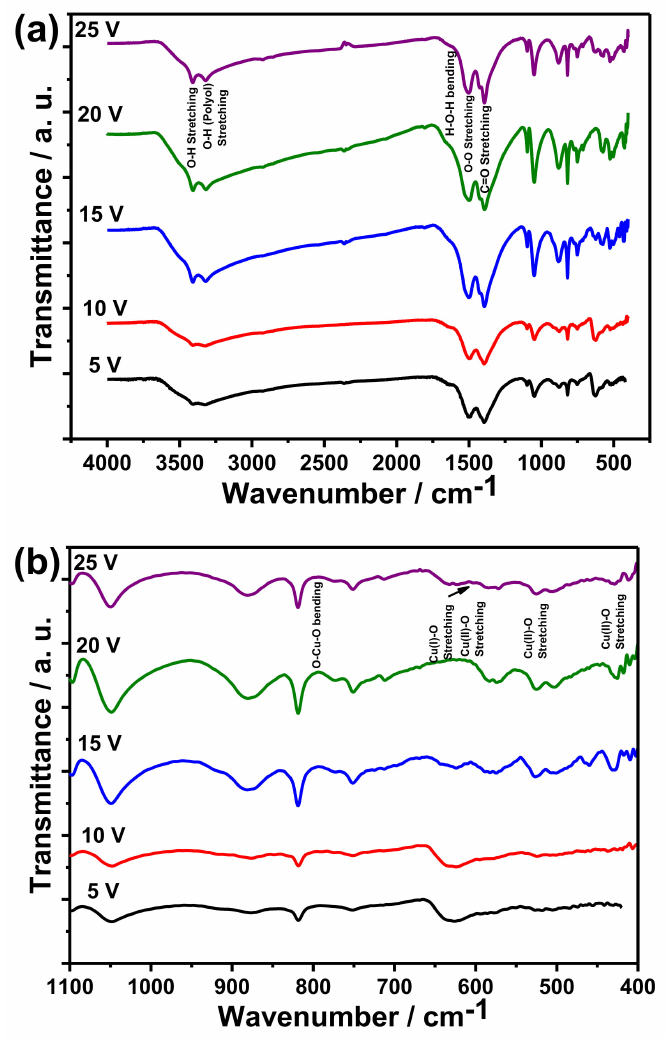
Figure 2. ( a ) FTIR spectra of the anodized copper foam in 0.1 M K 2 CO 3 at 5, 10, 15, 20, 25, and 25 V; and ( b ) enlarged FTIR spectra in the range of 400–1100 cm − 1 .